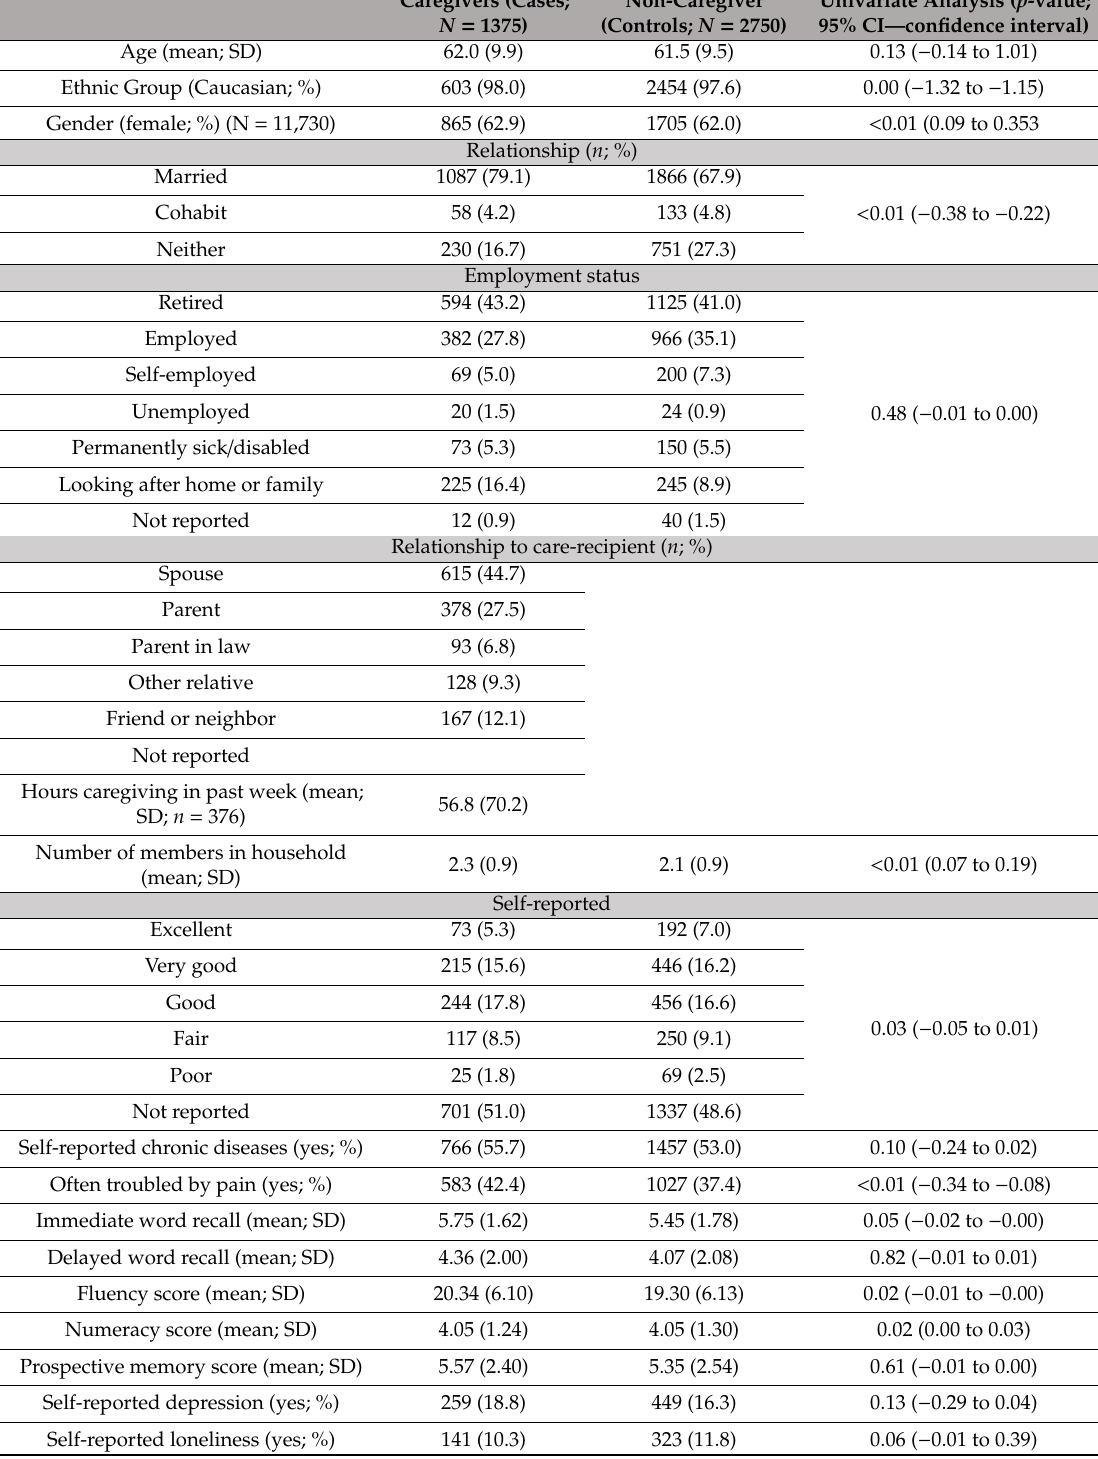
Table 1. Summary of demographic and biopsychosocial factors characterizing the informal caregiver (cases) and non-informal caregiver